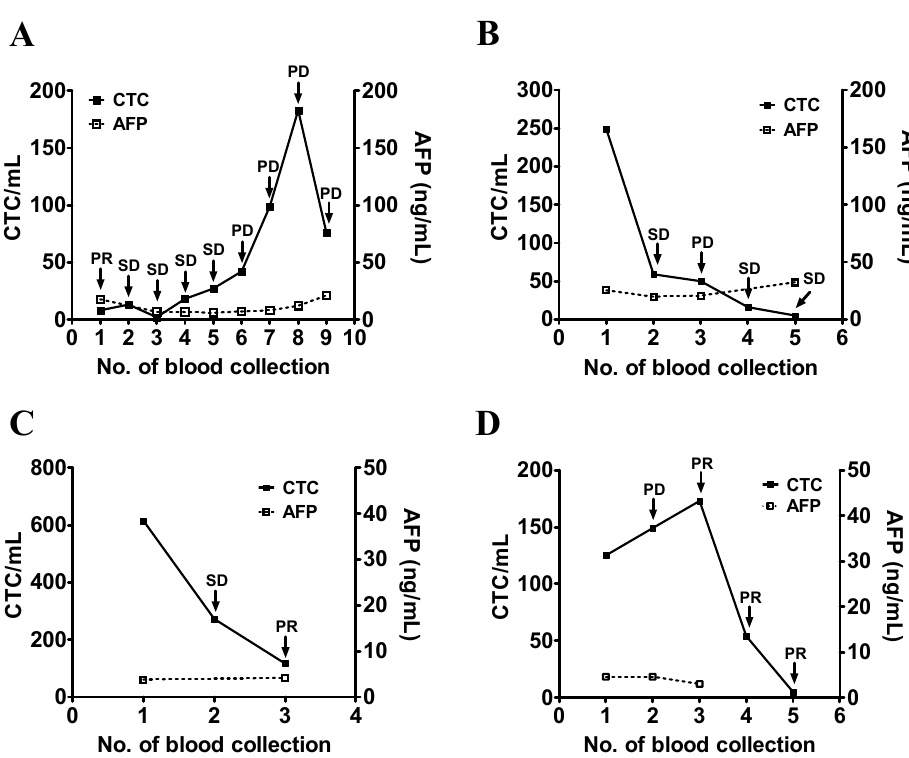
Figure 6. Longitudinal follow-up of the CTC counts for monitoring the disease status of patients with HCC (part IV). ( A – D ) The blood samples were longitudinally collected from patients #3 (panel A ), #23 (panel B ), #26 (panel C ), and #27 (panel D ), who all had a normal serum AFP level throughout the study. Series testing of the CTC count and the serum AFP level were performed and plotted accordingly. The disease status (SD, PR, and PD) was determined and was used as an indicator of the patient’s clinical outcome.